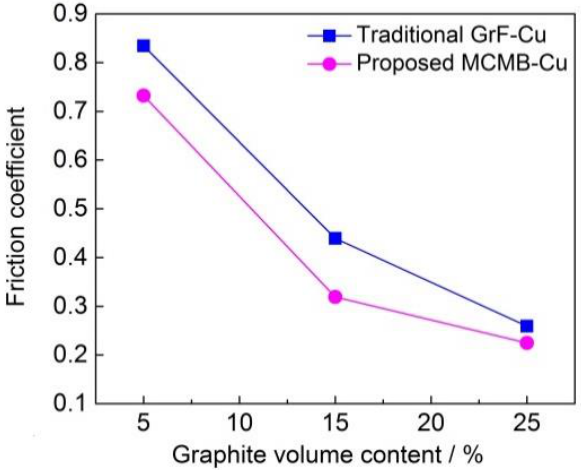
Figure 8. Friction coe ffi cients of the MCMB–Cu and GrF–Cu composites under di ff erent MCMB and GrF volume contents.